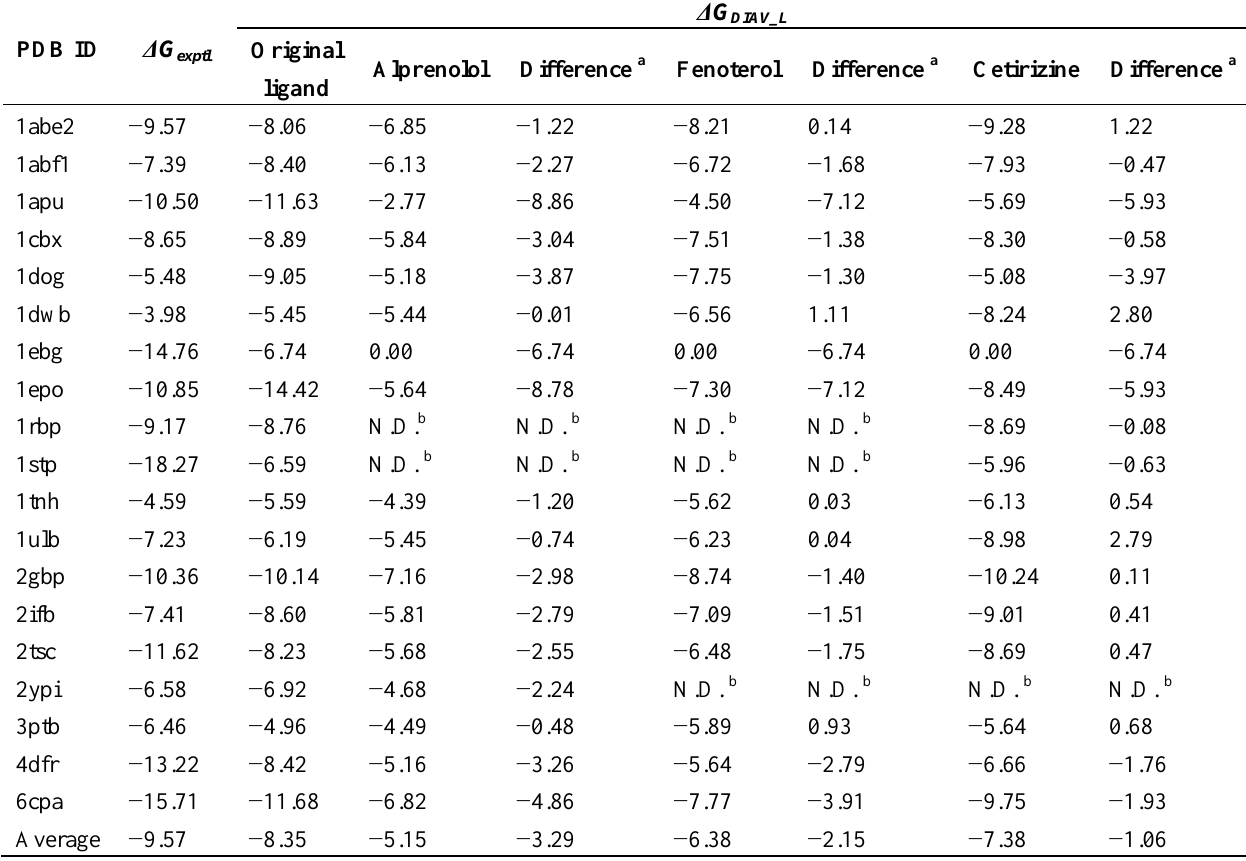
Table 3. The binding free energies estimated for the non-active compounds